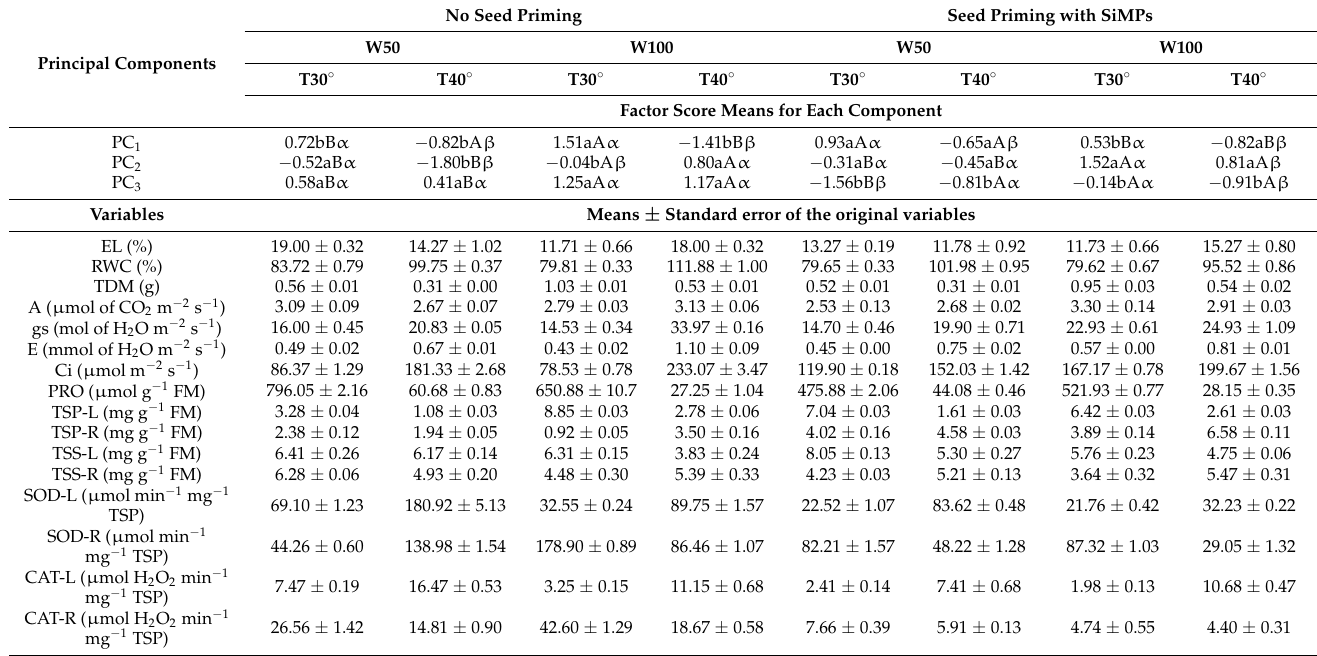
Table 2. Means of factor scores for each component and means ± standard error of the original variables evaluated as a function of the interaction between seed priming, soil water replacement levels, and temperature change in Moringa oleifera